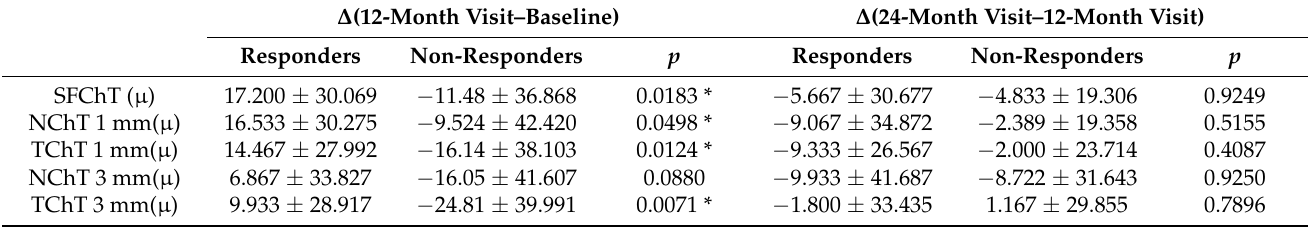
Table 3. Changes (mean ± SD) in subfoveal choroidal thickness (SFChT), nasal choroidal thickness at 1 mm (NChT 0.5 mm), temporal choroidal thickness at 1 mm (TChT 0.5 mm), nasal choroidal thickness at 3 mm (NChT 1.5 mm), and temporal choroidal thickness at 3 mm (TChT 1.5 mm)